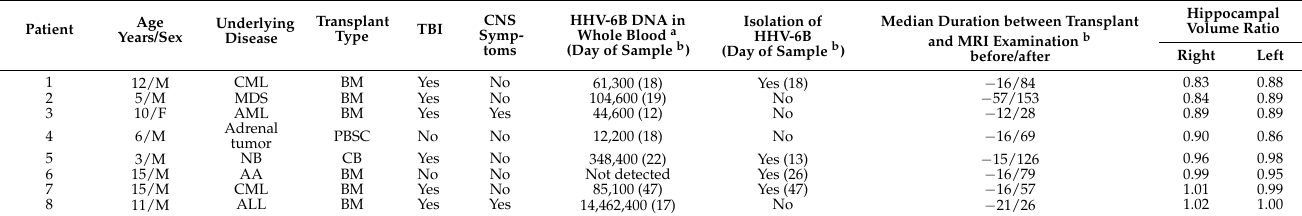
Table 2. Characteristics and laboratory and MRI findings of eight patients with HHV-6B